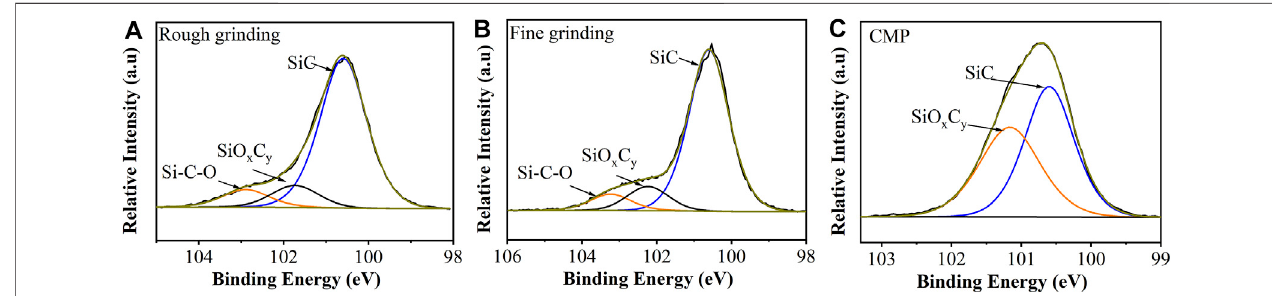
FIGURE 9 | Si 2p XPS spectra of (A) rough grinding, (B) fi ne grinding, and (C) CMP 4H-SiC wafers.